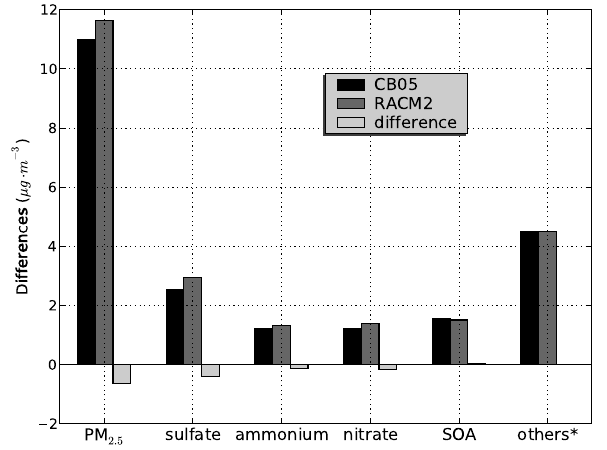
Fig. 2. Domain-averaged differences of the concentrations of PM 2 . 5 and PM 2 . 5 chemical components between the two mechanisms, CB05 and RACM2. ∗ : mineral dust, black carbon, sea salts and primary organic